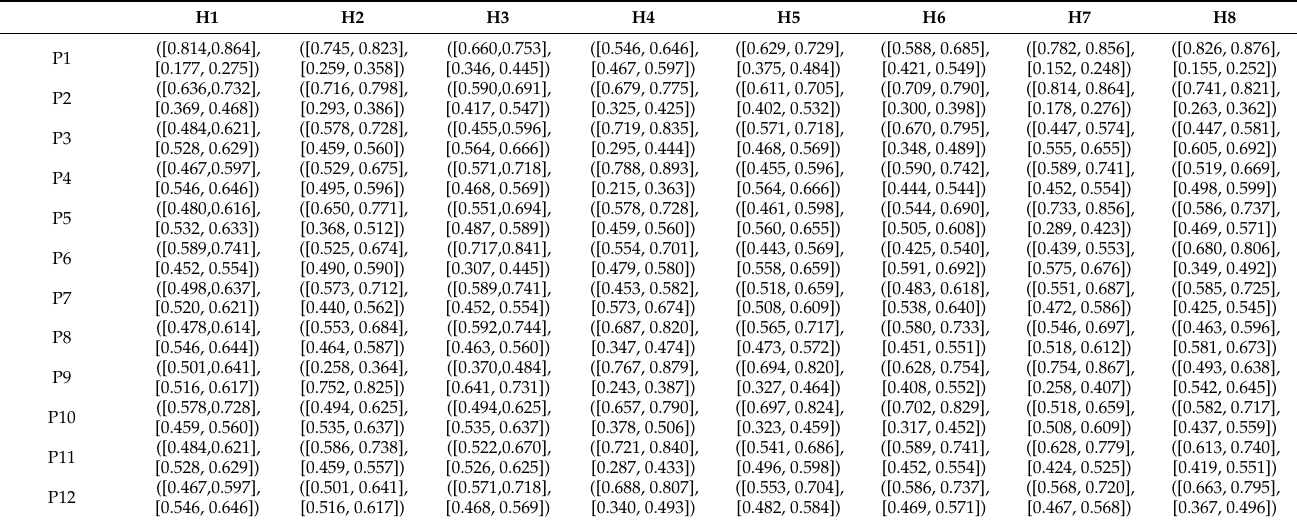
Table 9. The N-A-IPF-DM of WTE technology for MSW treatment alternatives.